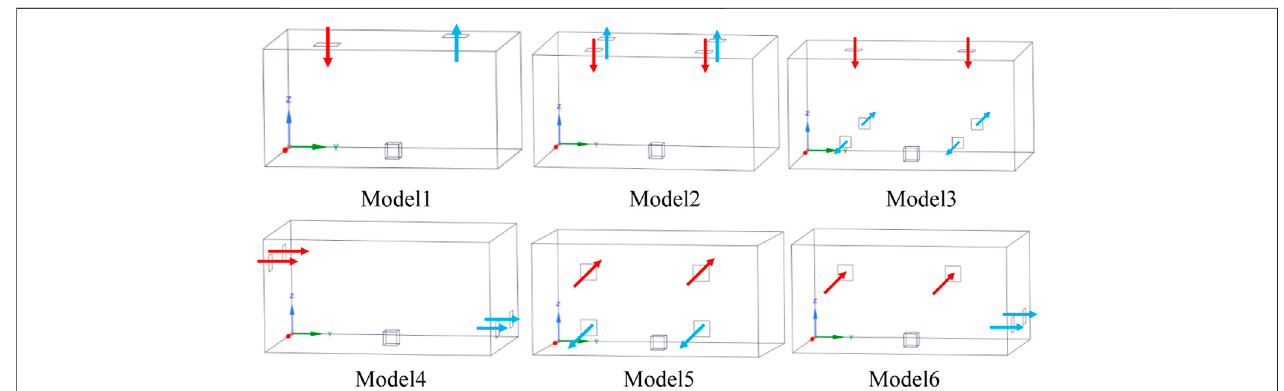
FIGURE 2 | Optimal design of the